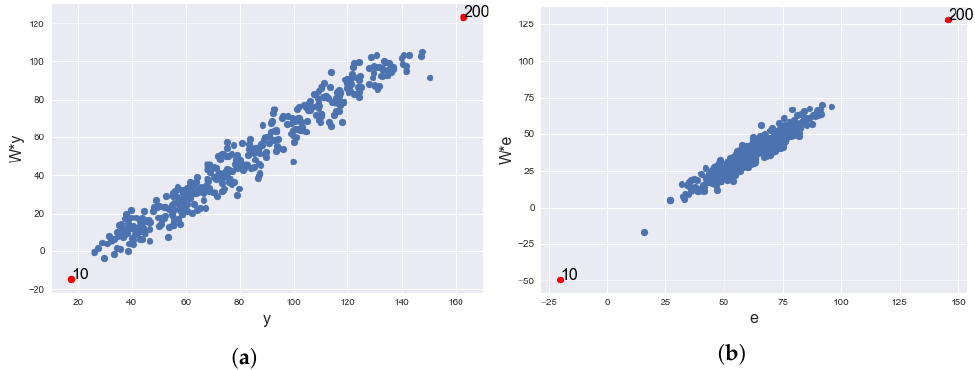
Figure 6. Scatter plot of ( a ) dependent variable against its average neighbour and ( b ) autocorrelated residual with its average neighbour in the simulated data for ρ = 0.4 and λ = 0.5 with two contamination (red dots) on the dependent variable, y . ( a ) y against Wy . ( b ) ξ against W ξ .